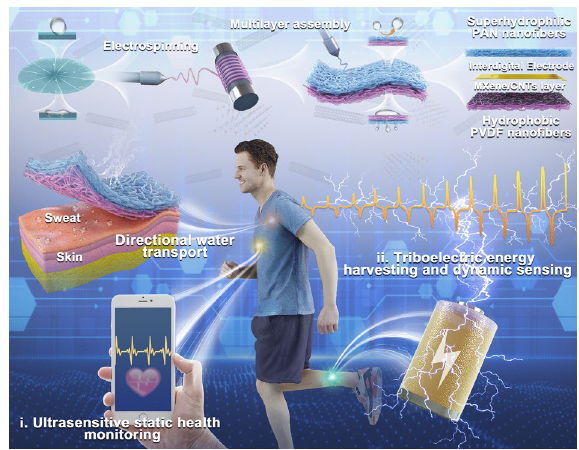
Fig. 1 Schematic illustration of the fabrication and application of the DMWES